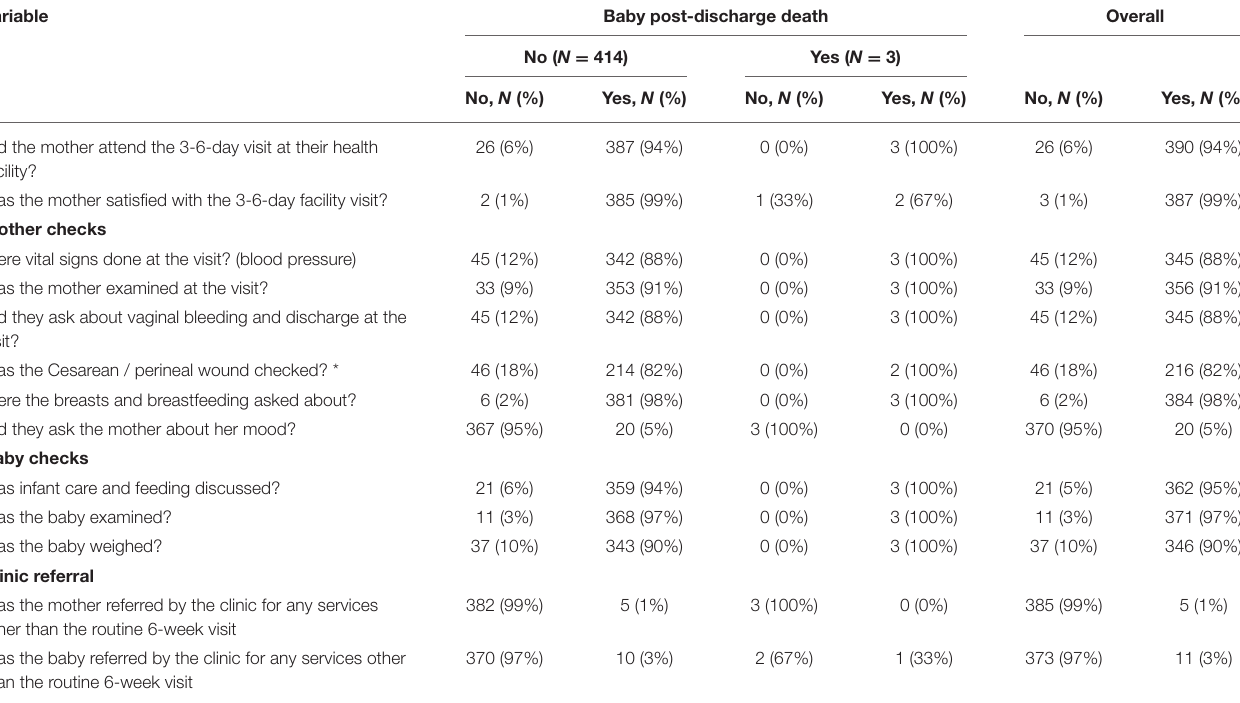
TABLE 3 | Description of 3-to-6-day visit and baby post-discharge death.